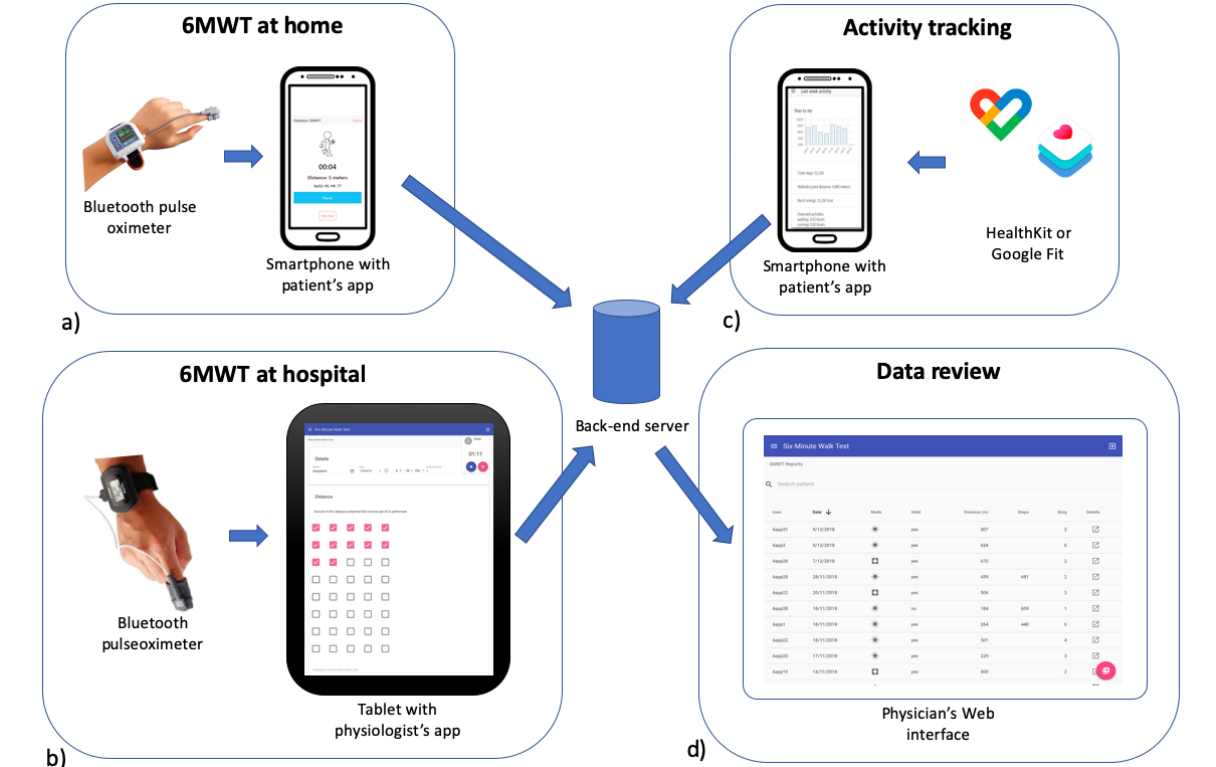
Figure 1. Architecture of the 6-min walk test (6MWT) system. It includes 4 scenarios: (a) 6MWT at home, where patients perform a 6MWT in their home setting using their mobile phone with the app and a wireless pulse oximeter; (b) 6MWT in the hospital, where patients perform the test while being observed by a physician and with pulse oximetry data being collected through a tablet app; (c) activity tracking data retrieved by Google Fit or HealthKit transmitted for subsequent analysis; (d) data review performed by a physician through a Web